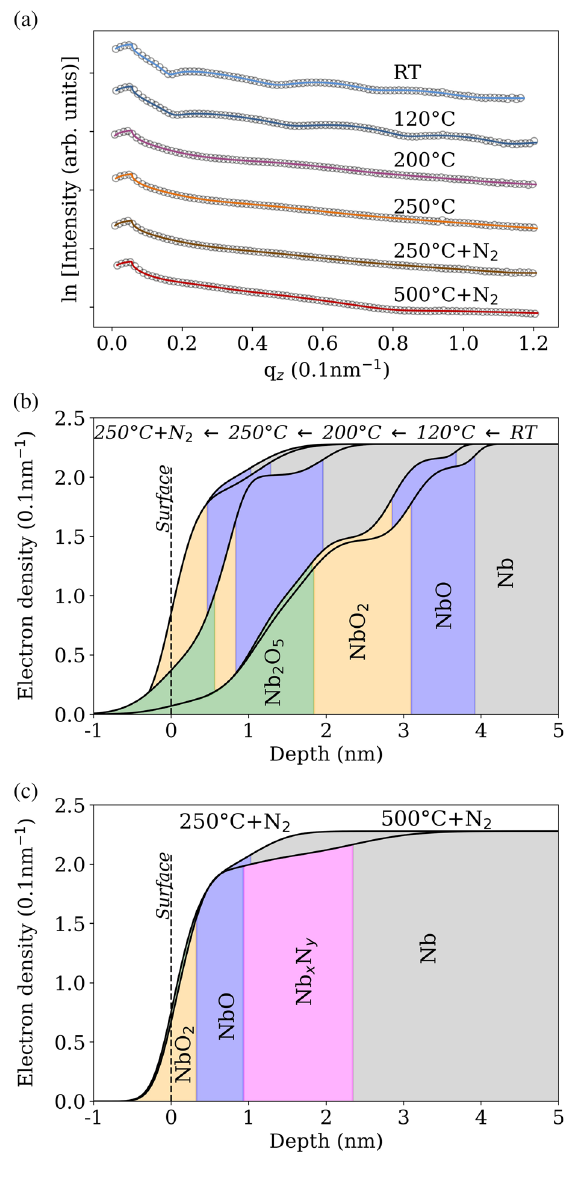
FIG. 5. (a) X-ray reflectivity data (open circles) measured with photon energies of 70 keV with the respective fits (solid lines). The scans are offset in the y direction. (b) Electron-density profiles obtained from the fits for the data collected from RT up to the addition of N 2 at 3 . 33 × 10 − 2 mbar at 250 °C. (c) Comparison between the electron density profiles obtained at 250 °C and 500 °C in a N